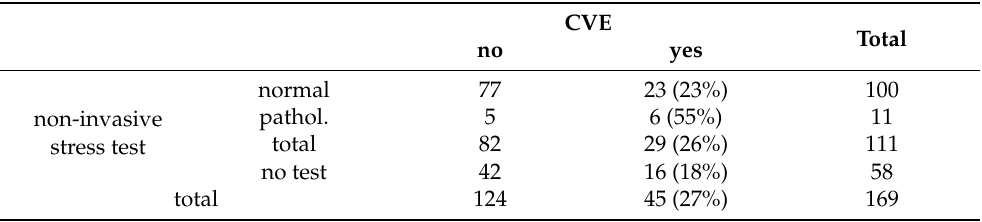
Table 3. Number of patients with and without a non-invasive stress test and their respective amount of